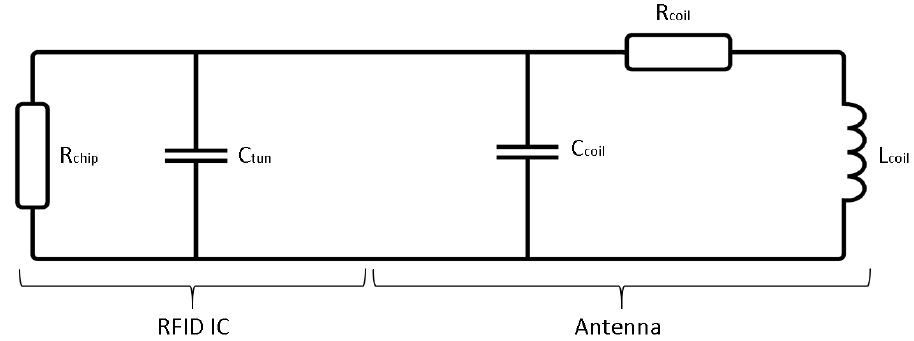
Figure 2. Equivalent circuit diagram of passive RFID